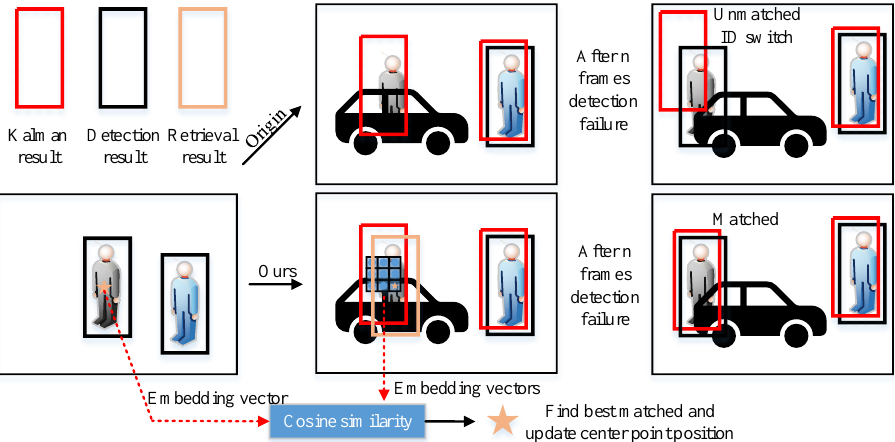
Figure 4. Tracking retrieval process. The five-pointed star indicates the position of the best matching embedding